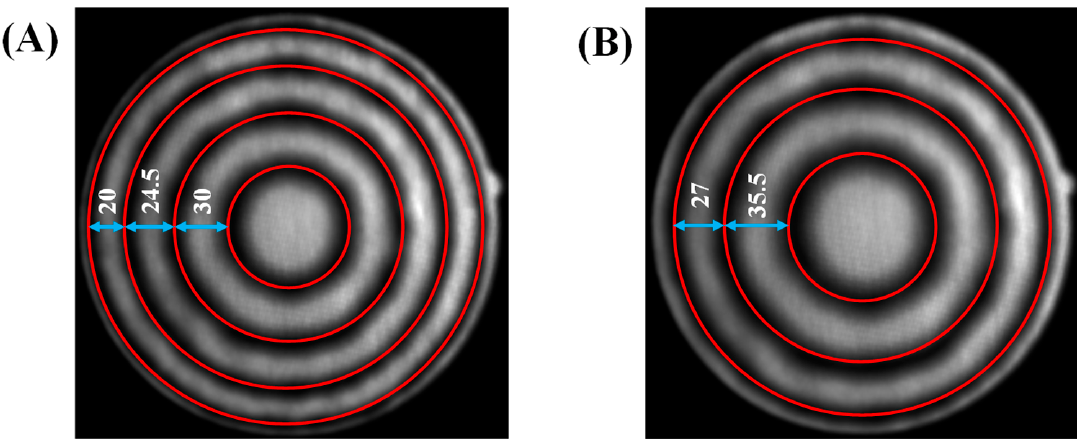
Figure 2. Effects of working distance and spatial location on horizontal measurements: ( A ) working distance of 2.87 mm, ( B ) working distance of 2.24 mm.